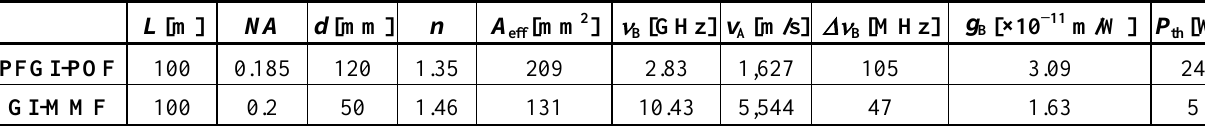
Table 1. Comparison of the material properties between the PFGI-POF and the GI-MMF used in this experiment: L , fiber length; NA , numerical aperture; d , core diameter; n , approximate refractive index of the core; A , effective cross-sectional area;  eff frequency shift; v , acoustic velocity;  , Brillouin linewidth; g A B coefficient; P , Brillouin threshold th